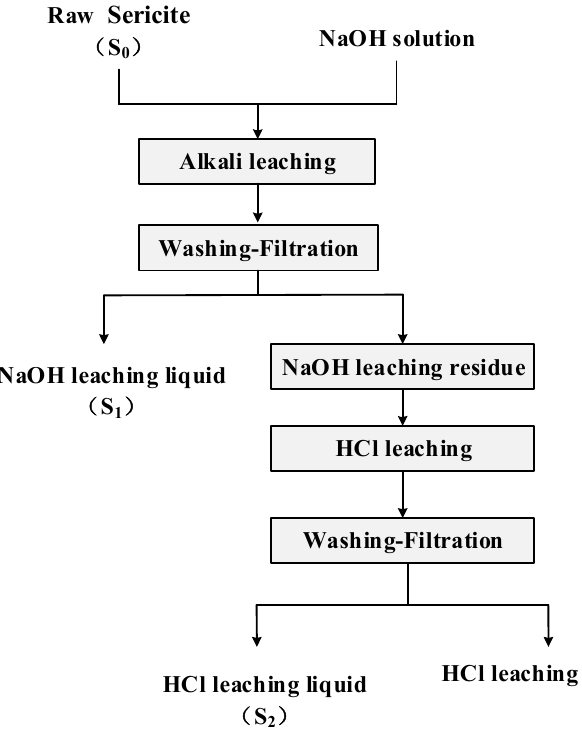
Figure 1. Process flow of alkali leaching–acid leaching of sericite.